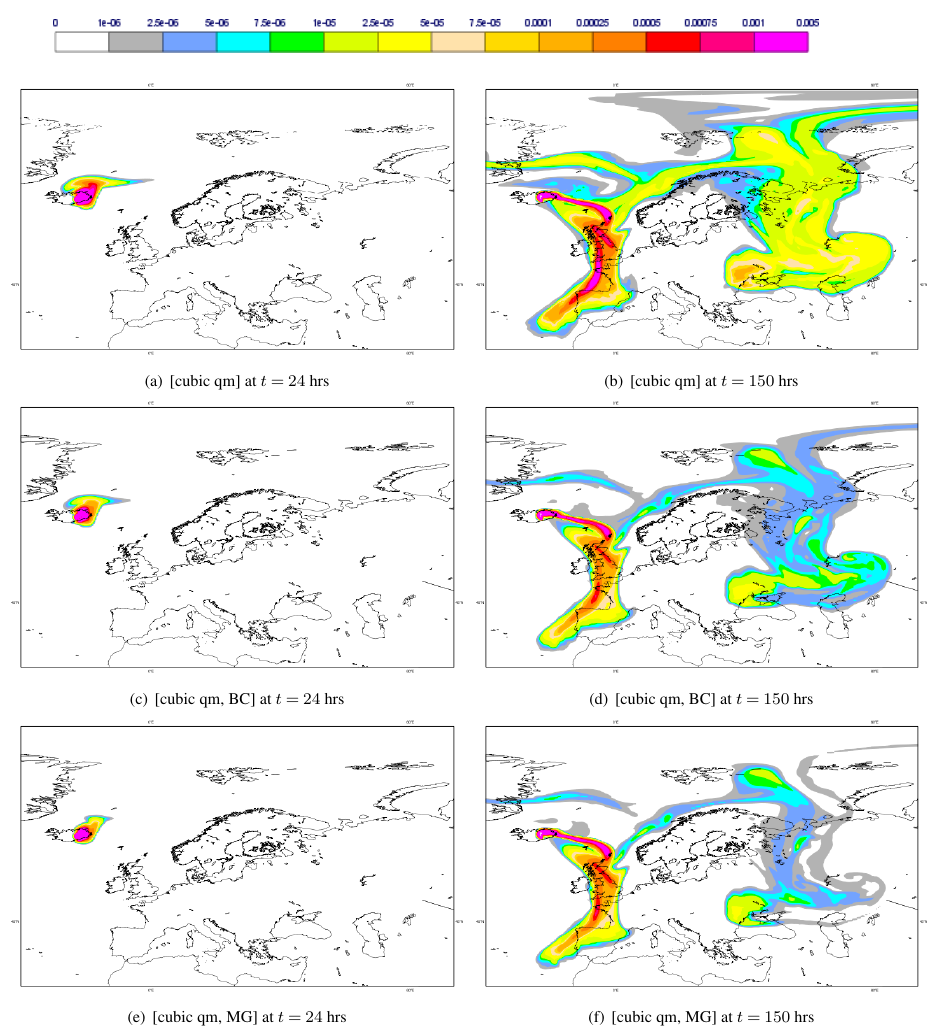
Fig. 9. Comparison of volcanic plume simulation with and without mass fixer using quasi-monotone cubic Figure 9. Comparison of volcanic plume simulation with and without a mass fixer using quasi-monotone cubic Lagrange at T1279 L91 Lagrange at T1279 L91 resolution. The plotted quantity is the total SO 2 content (in kg / m 2 ) per model grid- resolution. The plotted quantity is the total SO 2 content (in kgm − 2 ) per model grid-point column. Experiments defined as in Table point column. Experiments defined as in Table 1.